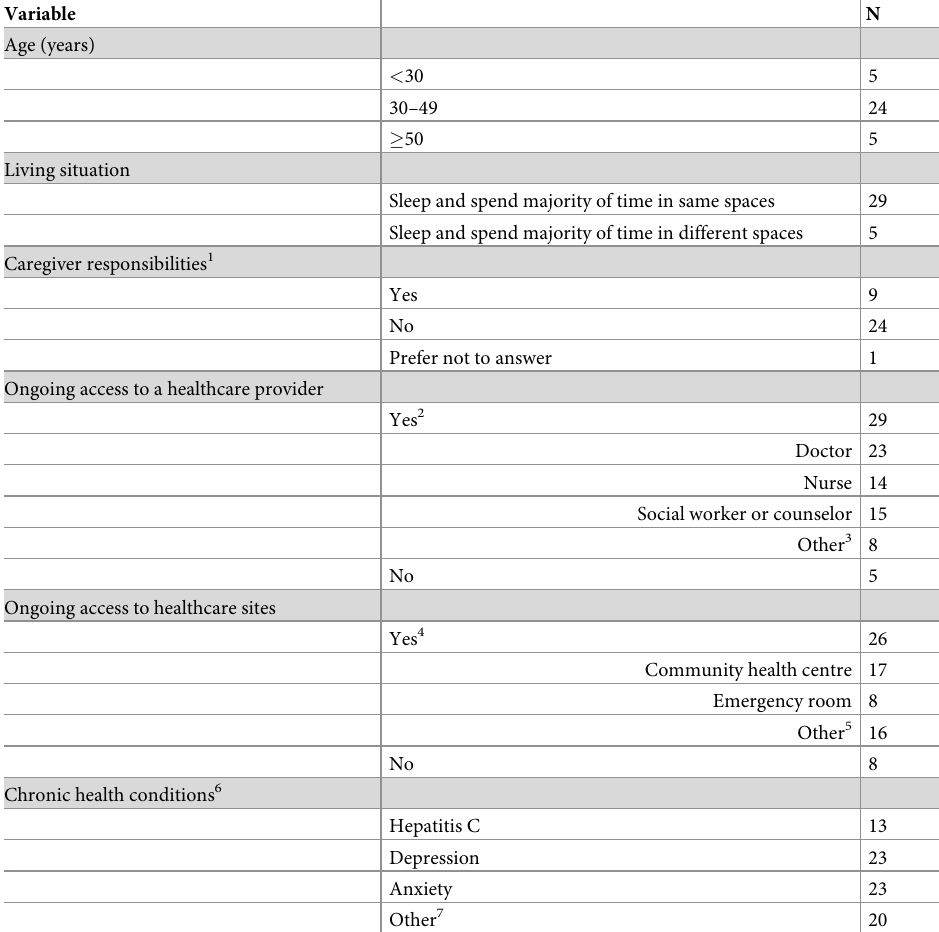
Table 1. Demographic characteristics of participants (n =